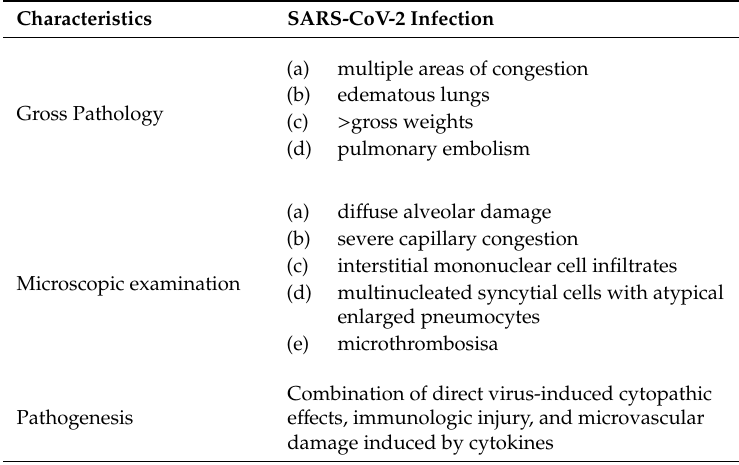
Table 1. Histopathological characteristics of lungs infected by